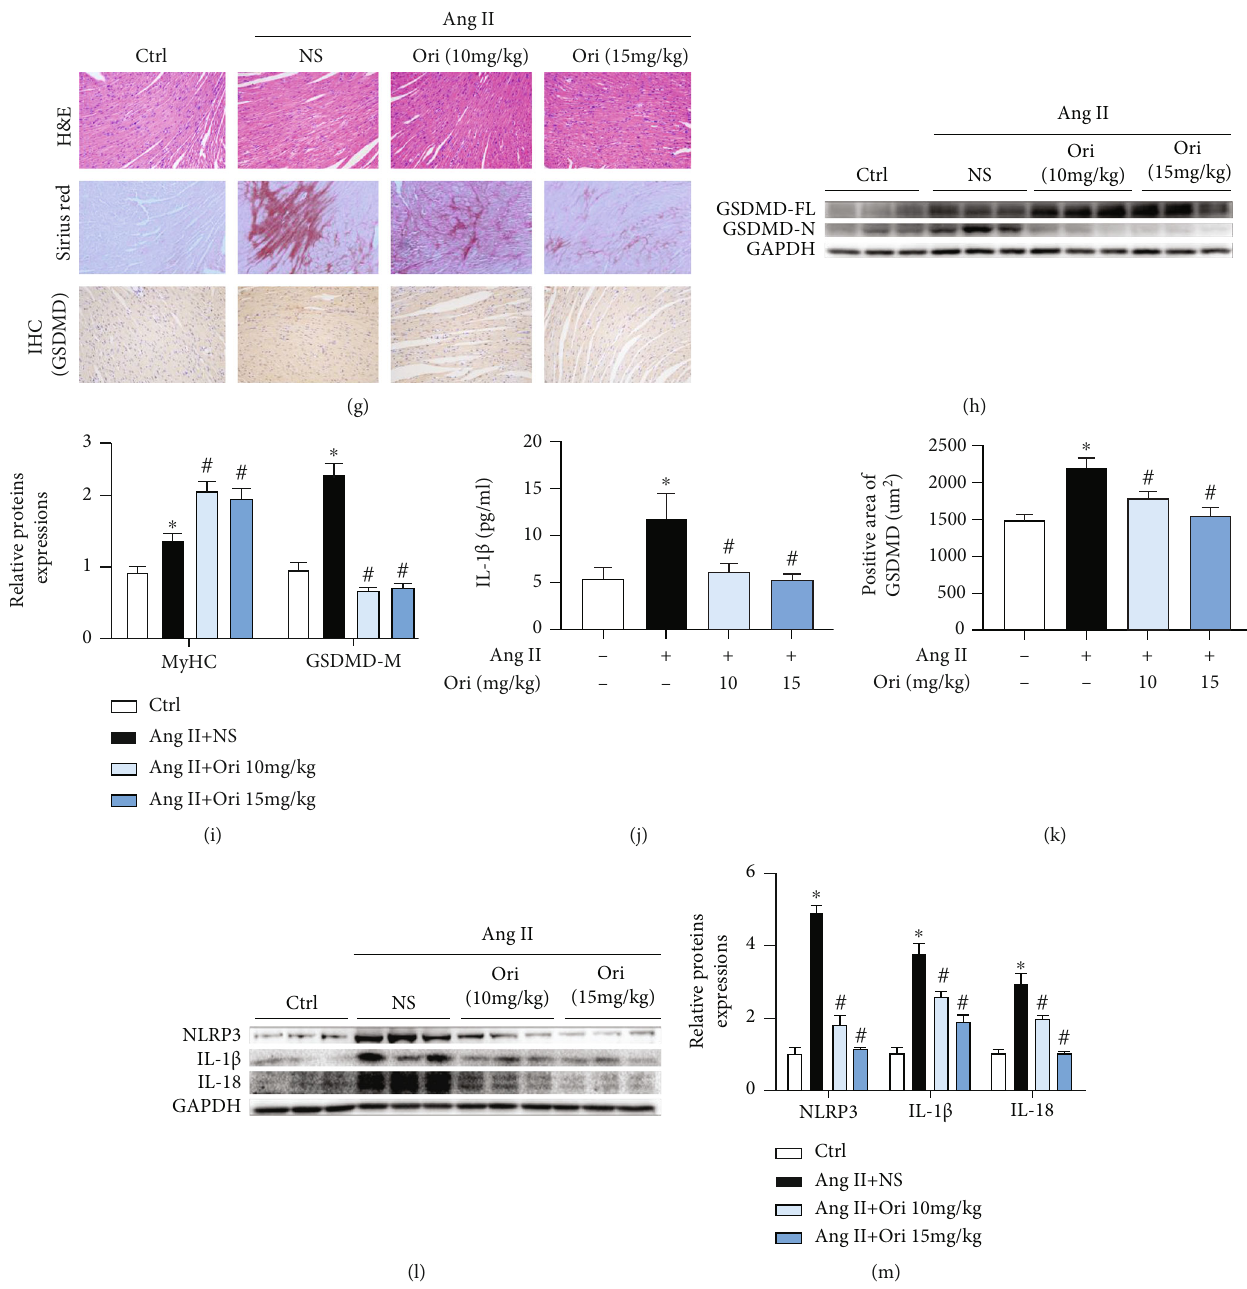
Figure 4: Oridonin attenuated myocardial cardiac remodeling by inhibiting GSDMD-mediated in fl ammation in vivo. The mice were examined with an echocardiogram at the end of the animal experiment. (a) Representative cardiac echocardiographic images of the four groups of mice. (b, c) EF and FS values for the four groups. (d) Changes in blood pressure in mice of each group during modeling. (e, f) Hypertrophy and fi brosis levels in cardiac tissue were detected by western blotting. (g) Representative H&E and Sirius red staining of each group also showed disordered myocardial cell structure and fi brosis in cardiac tissue. (g – i) The results of IHC showed the di ff erent expression levels of GSDMD in cardiac tissue corresponding to the results of western blot. (j) The content of IL-1 β in serum. (k) The relevant semiquantitative statistical graph of GSDMD-IHC. (l, m) Gel images of NLRP3, IL-1 β , and IL-18 in myocardial tissue and its semiquantitative statistical graph. ∗ p < 0 : 05 compared with control; # p < 0 : 05 compared with Ang II. EF: ejection fraction; FS: fractional